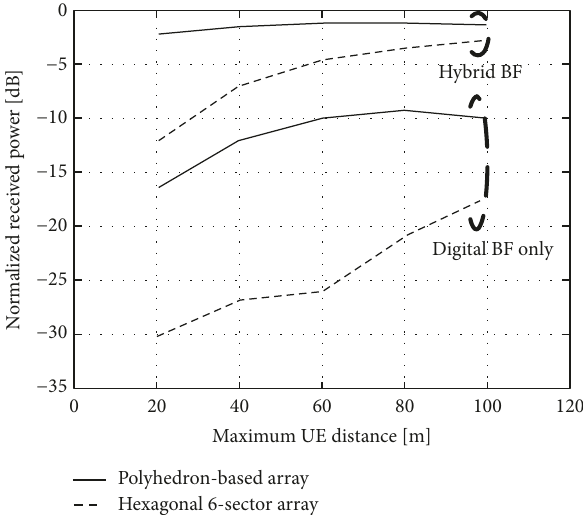
Figure 8: Average received power for the 2D UE distribution.